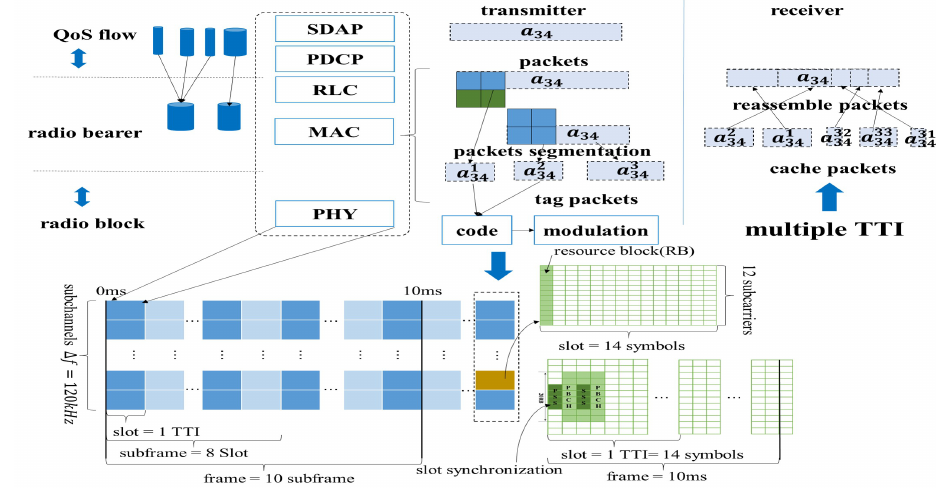
Figure 6. Adaptive task block segmentation scheme based on irregular gradient